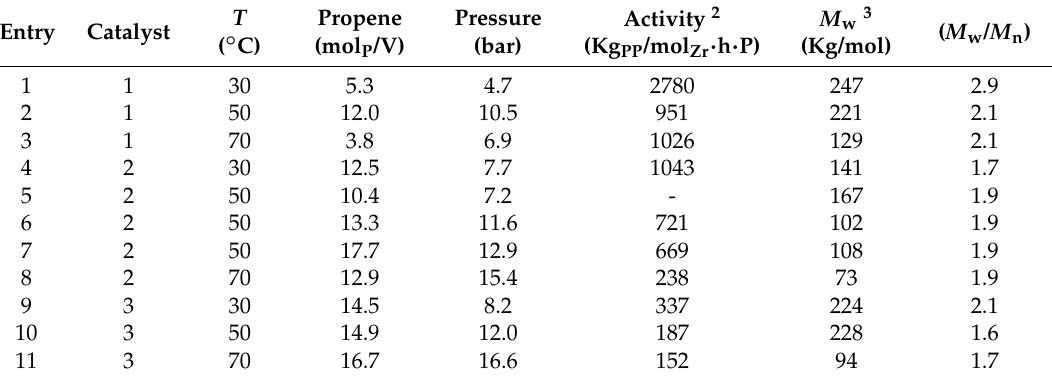
Table 1. Propene Homopolymerization in Autoclave: Activity and Molar Masses 1